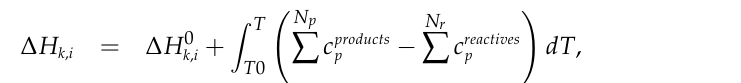
Table 1. Estimation methods for predicting the density and specific heat of the reaction mixture. Compound Charac. ρ Triglyceride Simple-molecule Fragments-based [54] Diglyceride